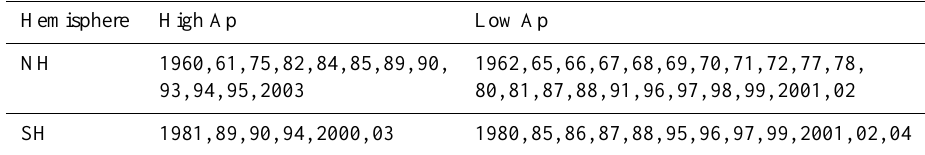
Table 1. Separation of data according to the Ap index. NH winters are referred to as 1961 for 1960/1961,